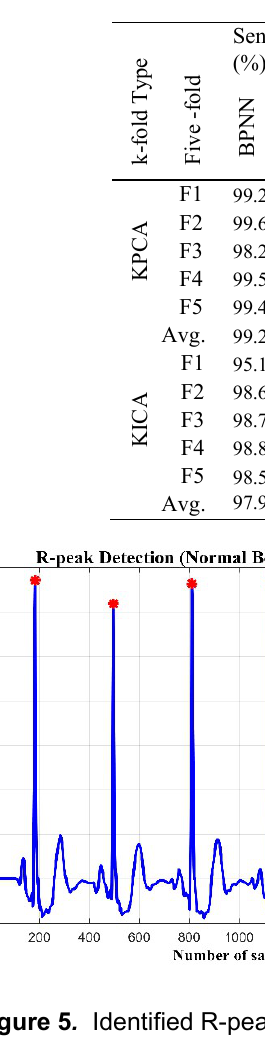
Figure 5 . Identified R-peaks of normal ECG